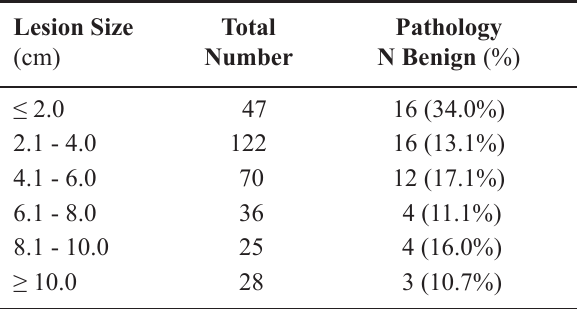
Table 3 – Frequency of benign disease for every cm increase in tumor